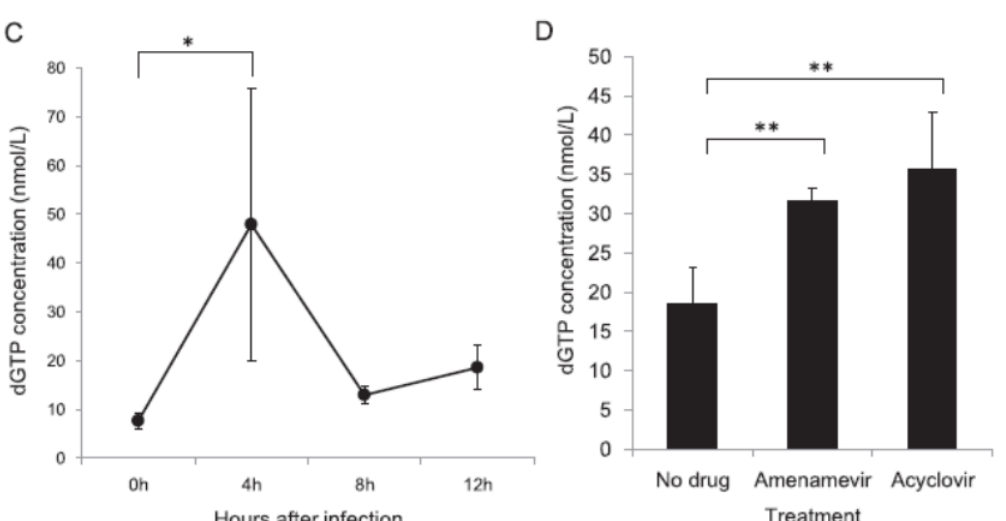
Figure 5. Time-dependent growth of HSV and concentration of dGTP after infection [18]. HSV DNA copy number and dGTP concentration were assessed serially in untreated HSV-infected cells or cells treated with acyclovir and amenamevir. ( A ) Time-dependent increase in HSV DNA copy number after infection. An increase in the copy number was observed later than 4 h after infection. ( B ) Comparison of HSV DNA copy number in cells immediately after infection at 0 h and in cells 12 h after infection treated with 10 times the EC 50 of amenamevir and acyclovir. The HSV DNA copy number was significantly higher in cells treated with acyclovir than in cells infected at 0 h and cells infected at 12 h and treated with amenamevir. ( C ) Time-dependent changes in the concentration of dGTP after infection. The concentration of dGTP was significantly increased at 4 h after infection and decreased thereafter. ( D ) The concentration of dGTP in infected cells at 12 h without drug treatment was significantly lower than that in infected cells treated with amenamevir and acyclovir. * and ** indicated p < 0.05 and p < 0.01, respectively. The authors obtained permission from Antiviral Research to reuse these figures [18].